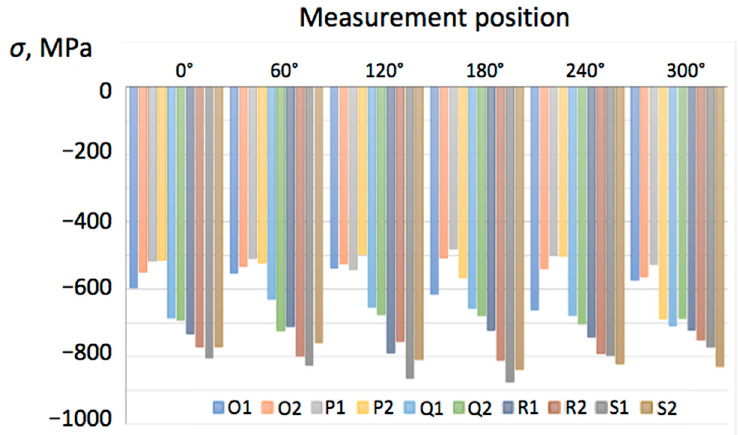
Figure 11. Results of normal residual stress σ measurement.